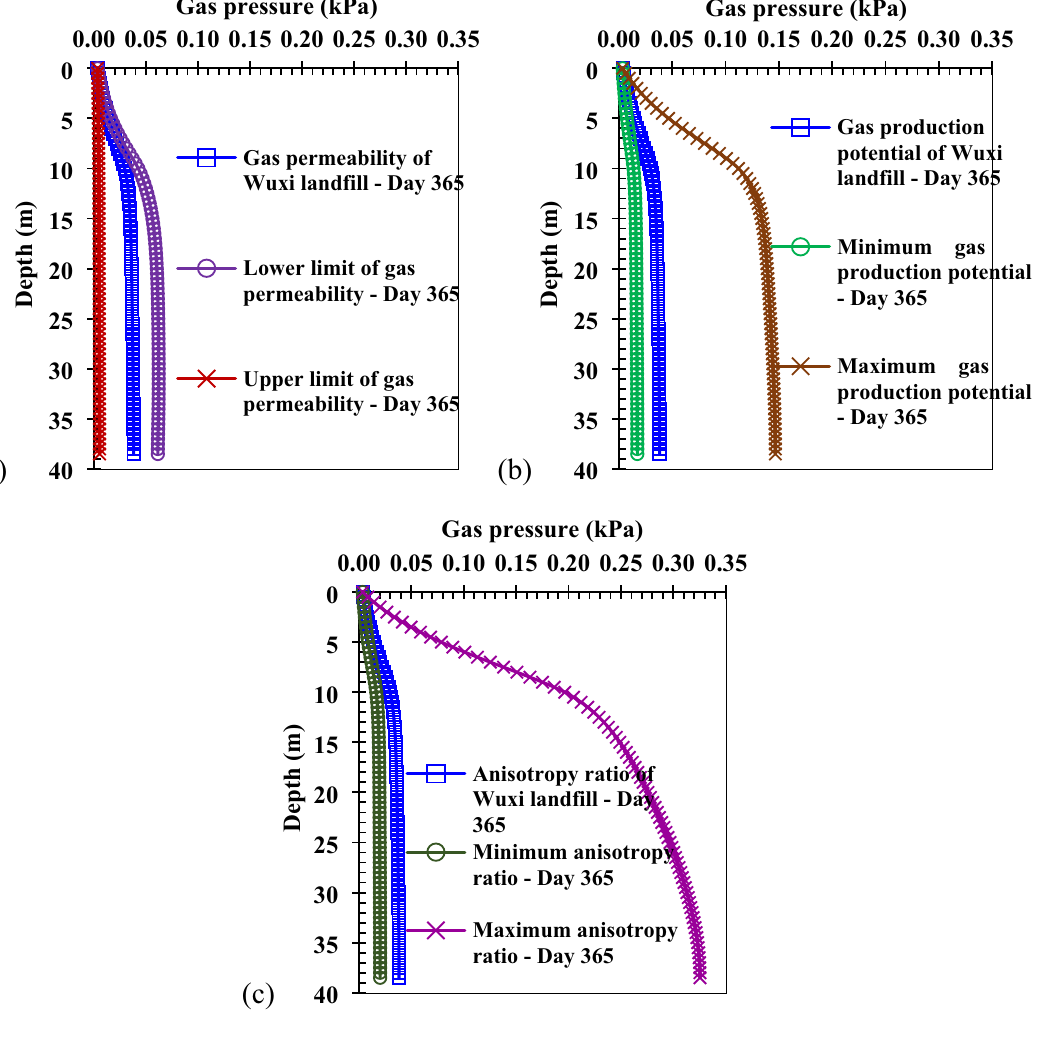
Figure 7. Comparison of gas pressure distribution under the conditions of different sensitive parameters: ( a ) gas permeability; ( b ) gas production potential (43.3–469 L kg −1 ); ( c ) anisotropy ratio